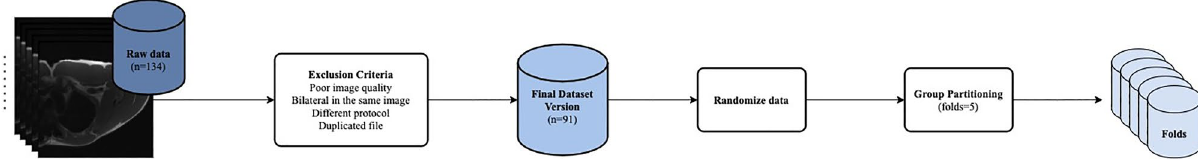
Figure 1. The flowchart depicts the project’s exclusion criteria and the workflow for data partitioning, as well as the final research